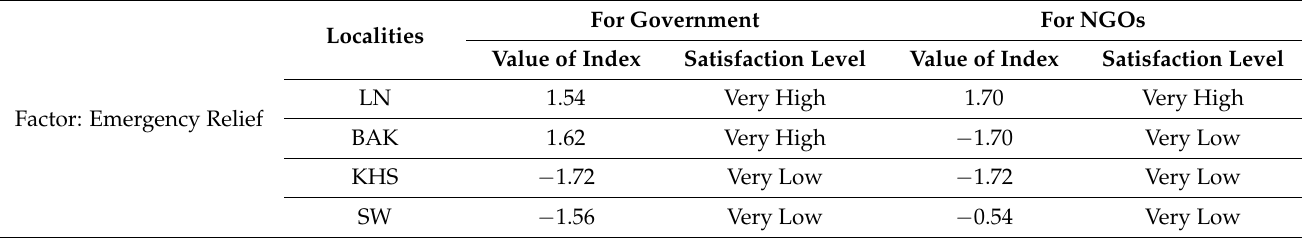
Table 2. Comparison of satisfaction level against emergency relief in 2010 floods between Government and NGOs. For Government For NGOs Localities Value of Index Satisfaction Level Value of Index Satisfaction Level LN Factor: Emergency Relief